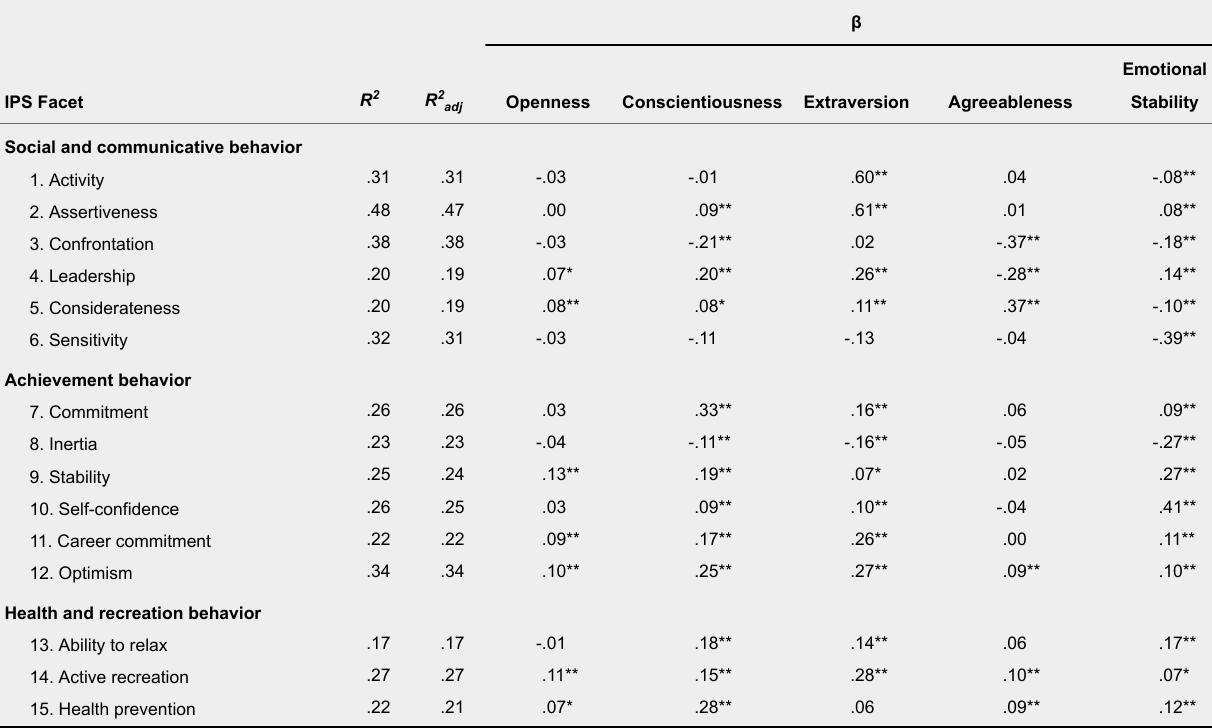
Summary of Regression Analyses of the Big Five on the IPS Facets